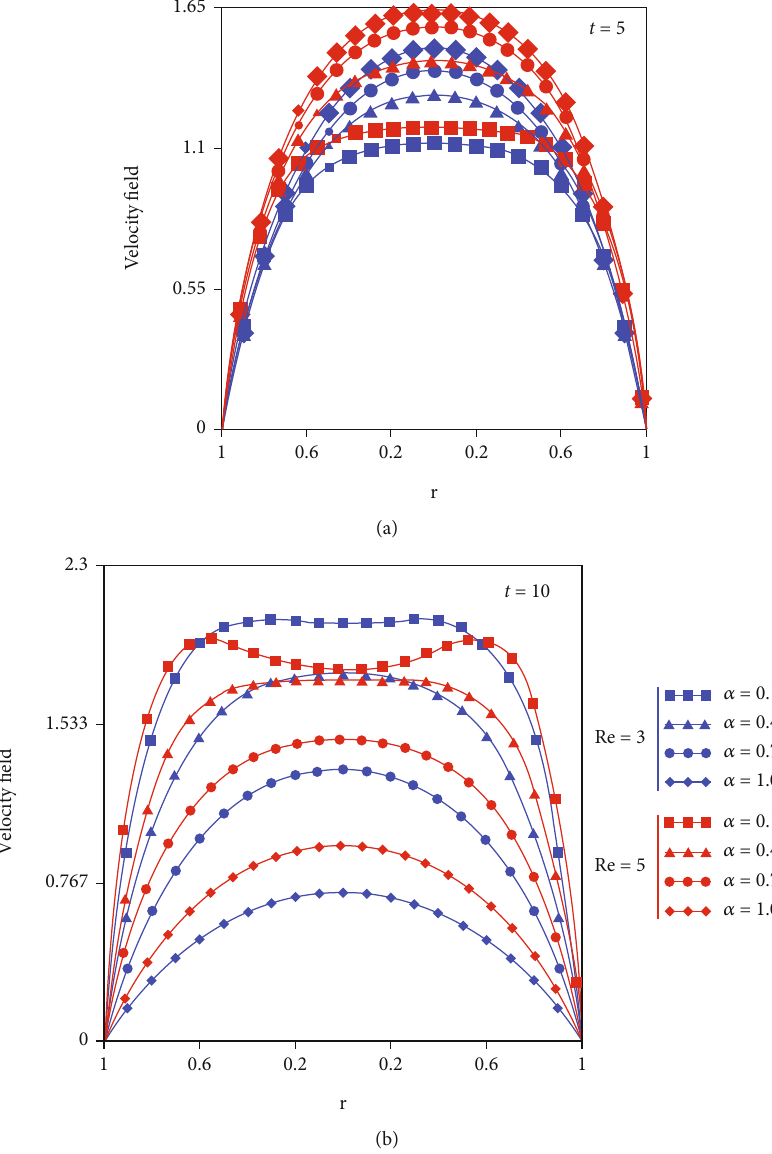
Figure 3: Pro fi les of dimensionless velocity for α versus r at Re = 3, 5, Ha = 0 : 5, K = 1, n = 0 : 8, for small and large values of time t